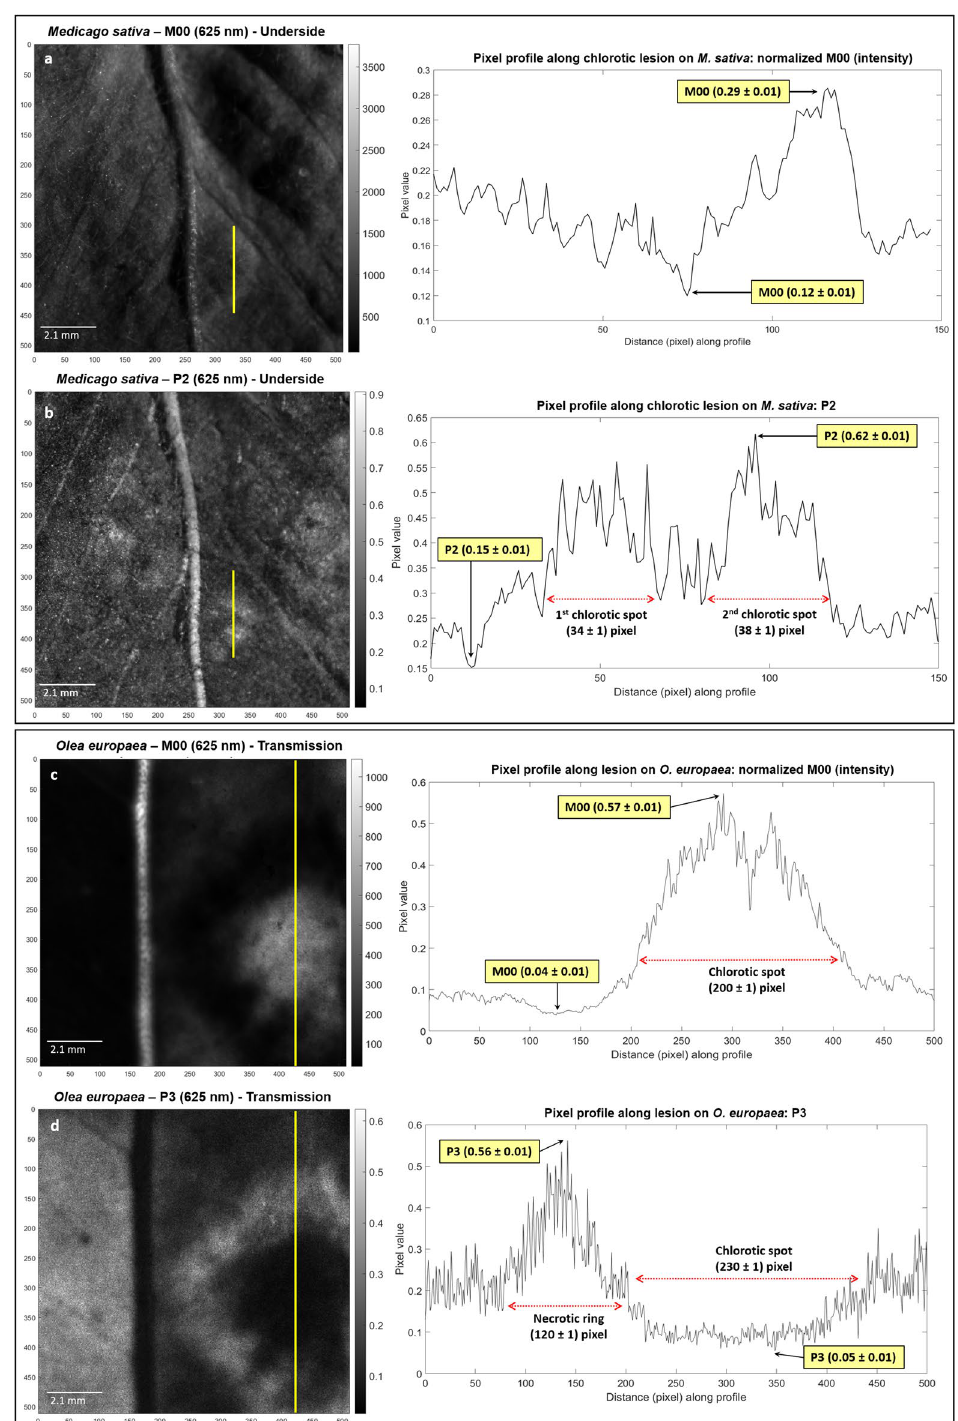
Figure 3. Pixel profile comparison for Medicago sativa and Olea europaea . ( a ) Intensity image at 625 nm of the underside part of M. sativa sample and its corresponding pixel profile, ( b ) polarimetric purity index P 2 and its corresponding pixel profile, ( c ) intensity image at 625 nm of the underside part of O. europaea sample and the corresponding healthy-necrotic-chlorotic transition pixel profile, and ( d ) polarimetric purity index P 3 and its corresponding pixel profile. The vertical yellow lines on polarimetric images indicate the plotted pixel profile segments. The squared numeric labels for M 00 , P 2 and P 3 indicate their respective highest and lowest pixel values within the inspected pixel regions. Red-dotted horizontal lines on plots indicate the diameter of the two chlorotic spots of M. sativa and width measurements for chlorotic spot and necrotic ring of O. europaea